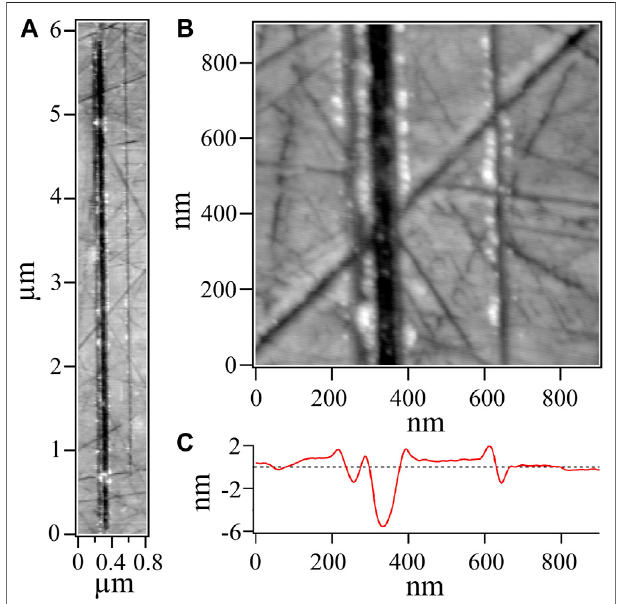
FIGURE3| Weartrackwithasinglescratche(category1).The Z -scaleis between − 10 nmand+5 nm fortheoverallimage (A) and ± 4 nmforthedetail image (B) . An average of all line pro fi les of the detail image is shown (C) .